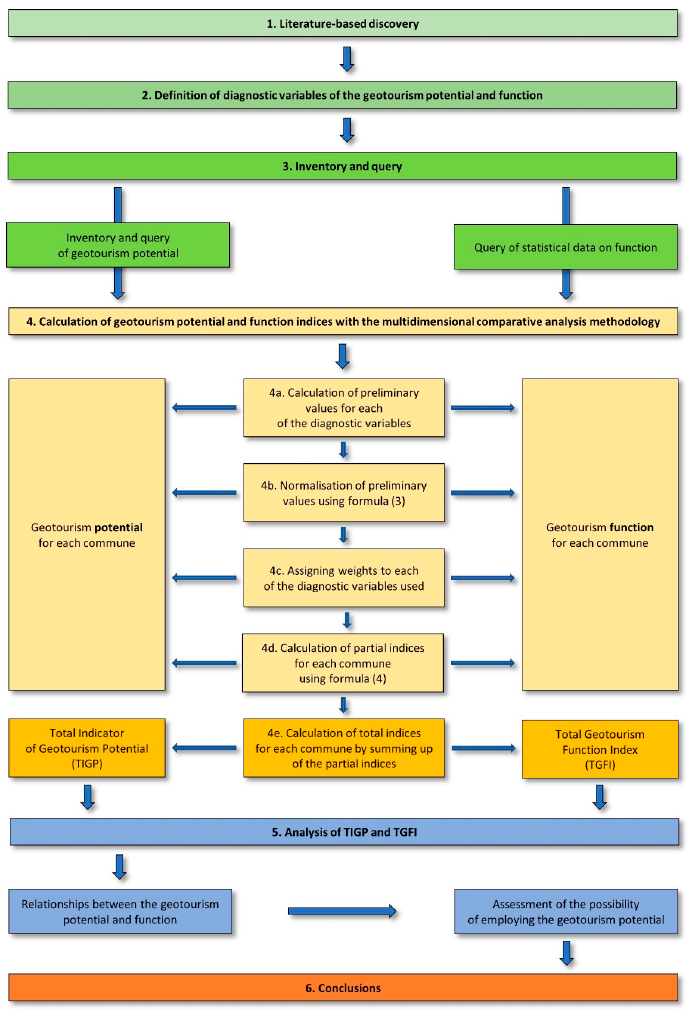
Figure 8. Research procedure scheme.